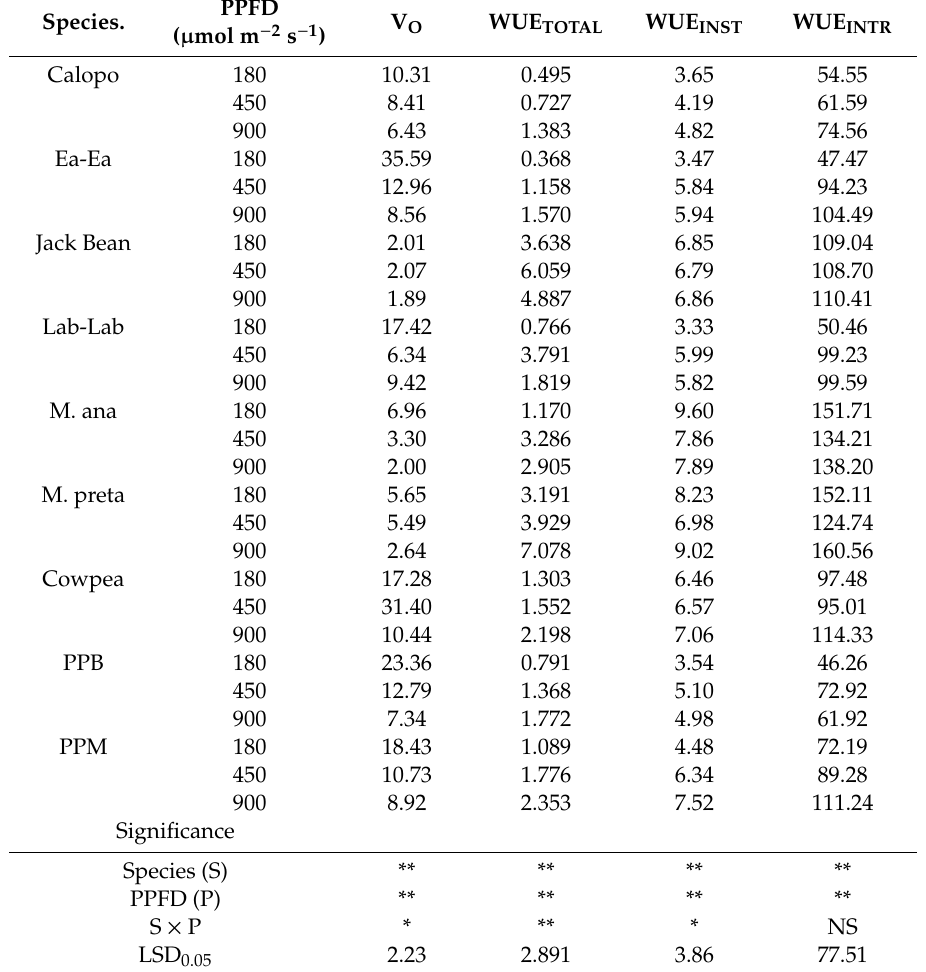
Table 4. E ff ect of photosynthetic photon flux density (PPFD) on water use e ffi ciency in cover crops.